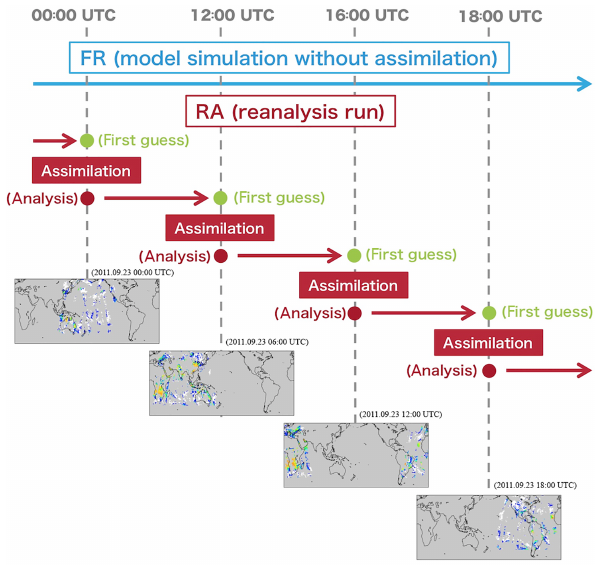
Figure 5. Schematic diagram of the reanalysis procedure. A map showing NRL-UND MODIS AODs is also shown at each assimila- tion